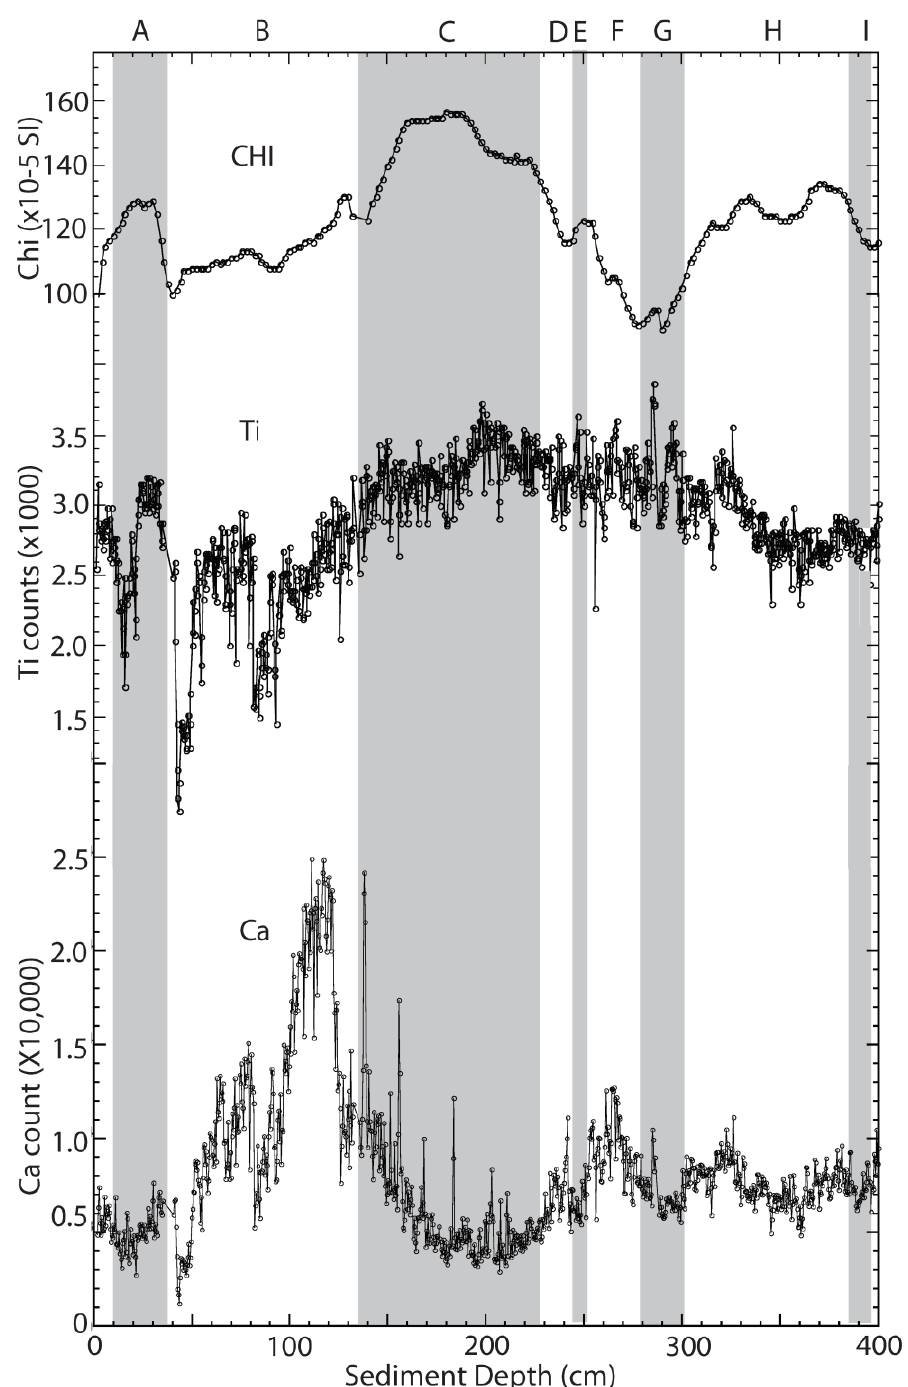
Figure 10. Proxy data for core 46CDH (Figure 1, Table 1), situated directly between gravity cores 9GGC and 25GGC. Top—magnetic susceptibility record; the variability can be directly correlated to data from 9GGC (Figure 2) and 25GGC (Figure 3). Below are Ti and Ca counts from unpublished XRF data on 46CDH (Delia Oppo, personal communication). The rock magnetic intensity zonation is consistent with the XRF data. High chi goes with high Ti (a clastic indicator; low chi goes with high Ca (a biologic indicator).